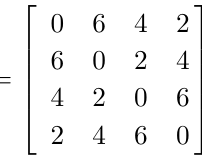
Table 4. { V M } 1 − { V M } 1 two-point correlator values. and in matrix